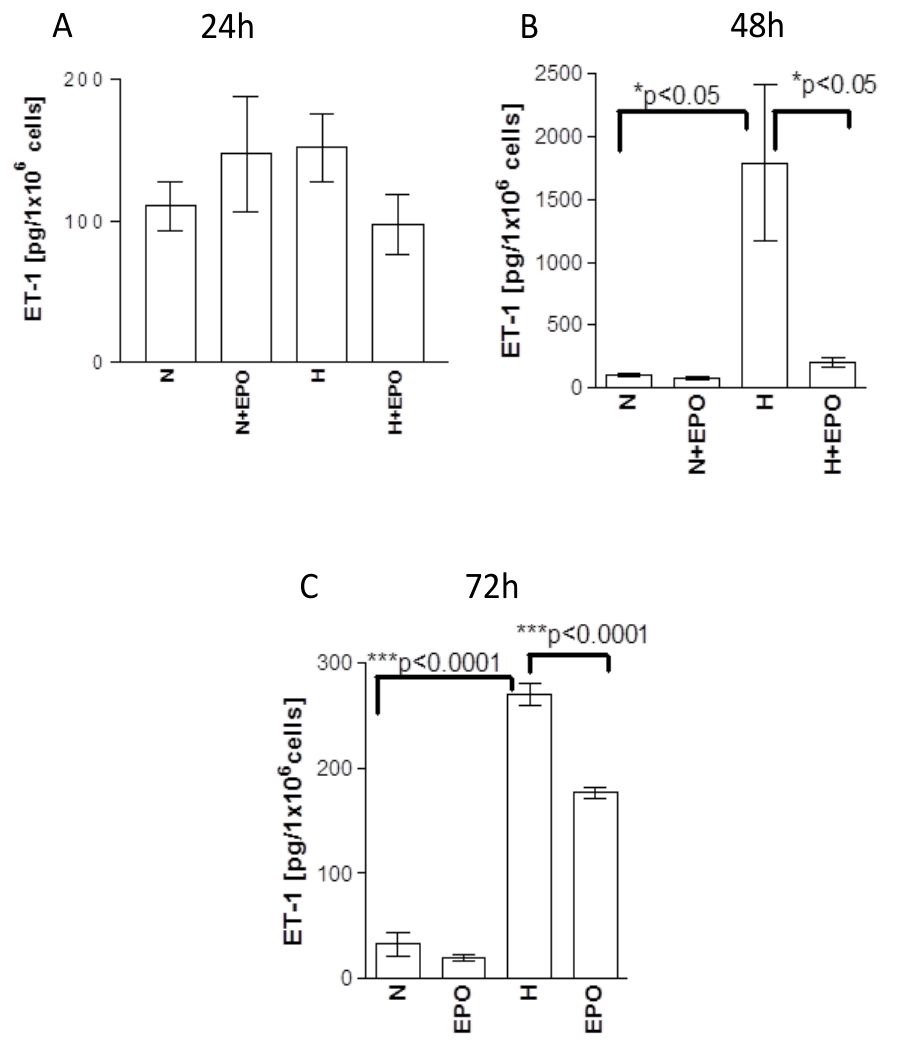
Figure 3. Release of ET-1 from human astrocytes ( A ) 24 h; ( B ) 48 h; and ( C ) 72 h after incubation with EPO under normoxic (N) and hypoxic (H) culture